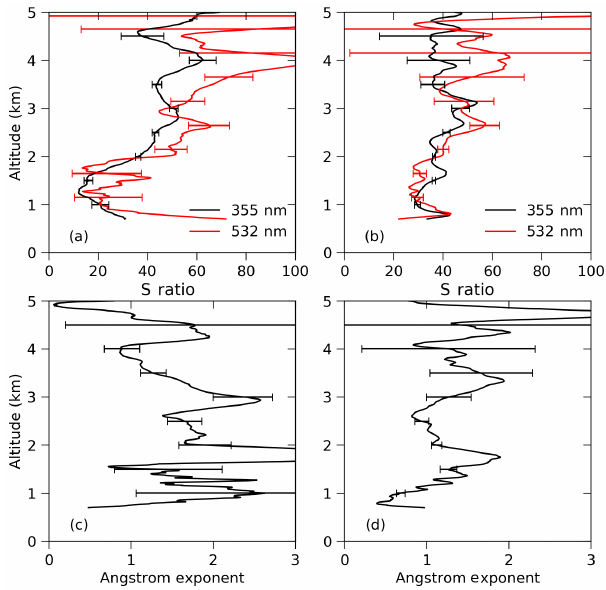
Figure 23. (a) S ratio plot of 355 and 532nm for 31 August, (b) S ratio plot of 355 and 532nm for 8 September, (c) extinction Ångström exponent for 31 August and (d) extinction Ångström ex- ponent for 8 September. Same 1h averages as Figs. 17 and